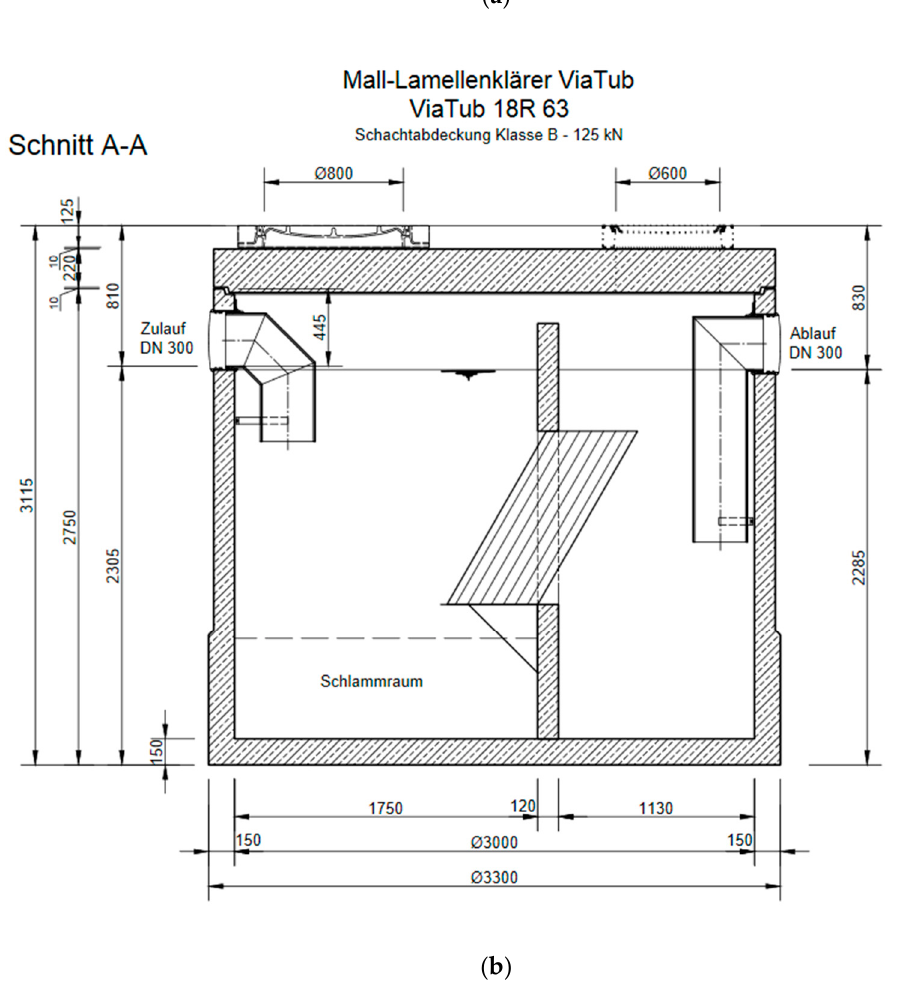
Figure A2. Illustration ( a ) and technical schematic ( b ) of the lamella clarifier (DS2) [48].